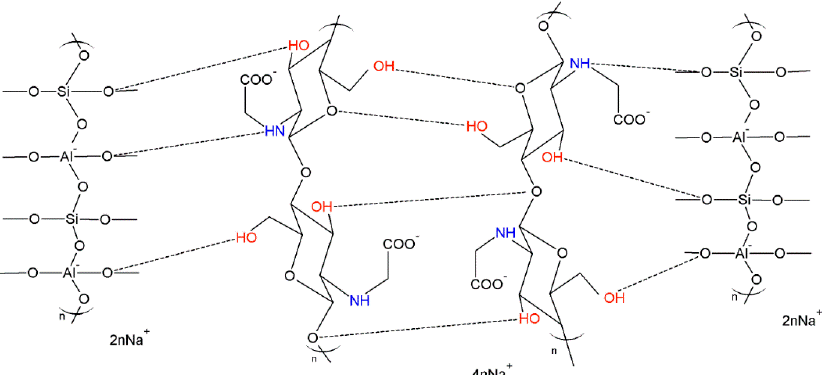
Figure 1. Schematic representation of the mechanism of interaction between geopolymer (on the left and on the right, in the hypothesis of Na/Al = 1:1) and N -carboxymethyl chitosan macromolecules (in the middle). Dashed lines represent hydrogen bonds [18].